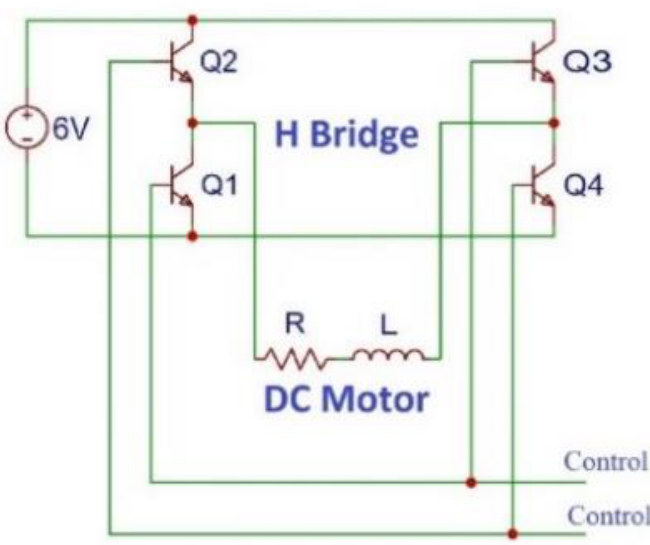
Figure 5. Wiring diagram of the electromechanical system.